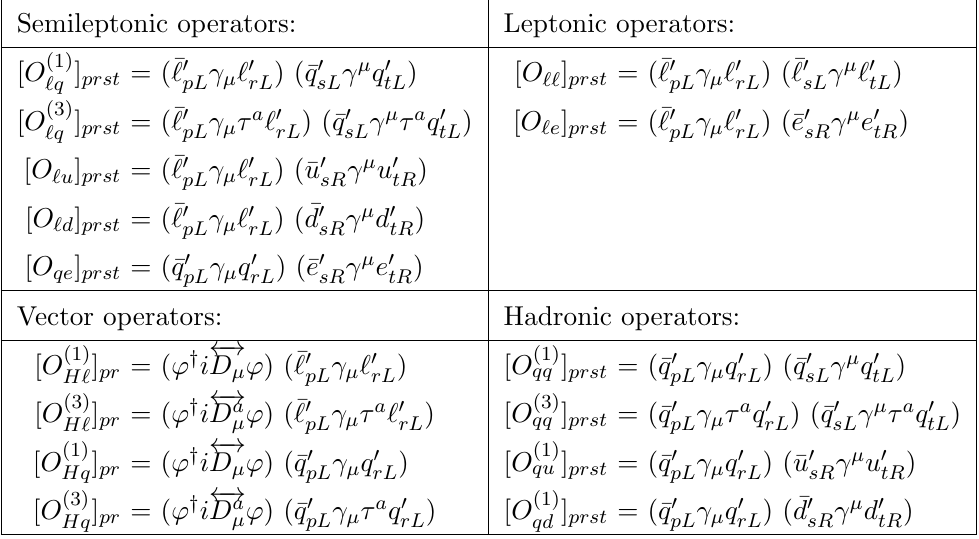
Table 1 . Minimal set of gauge-invariant operators involved in the RGE (cid:13)ow considered in this paper. Fields are in the interaction basis to maintain explicit SU(2) (cid:2) U(1) gauge invariance. Our notation and conventions are as in [50,